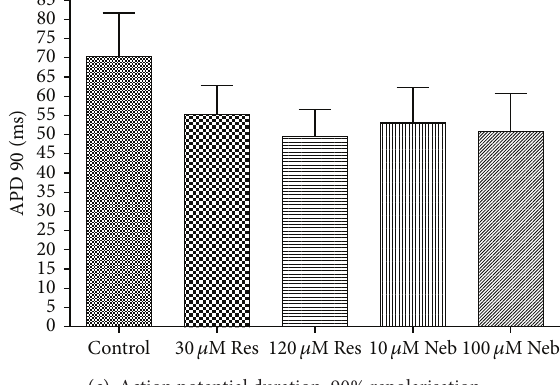
Figure1:Effectsofvariousdosesofresveratrolandnebivololontheactionpotentialdurationinnormalratpapillarymuscles.Res:resveratrol; Neb: Nebivolol. (a) Action potential duration at 20% of repolarisation. (b) Action potential duration at 50% of repolarisation. (c) Action potential duration at 90% of repolarisation. Data presented as mean ± SEM; 𝑛 = 5 – 8